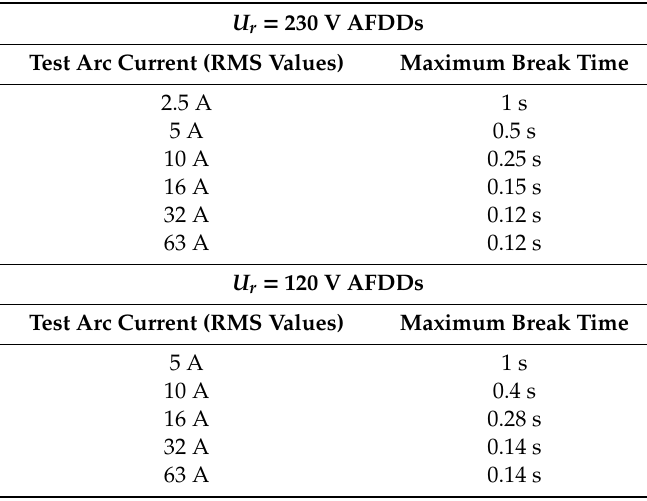
Table 3. Maximum allowed number of arcing half-cycles within 0.5 s for U r = 230 V AFDDs and U r = 120 V AFDDs in the parallel arc test.